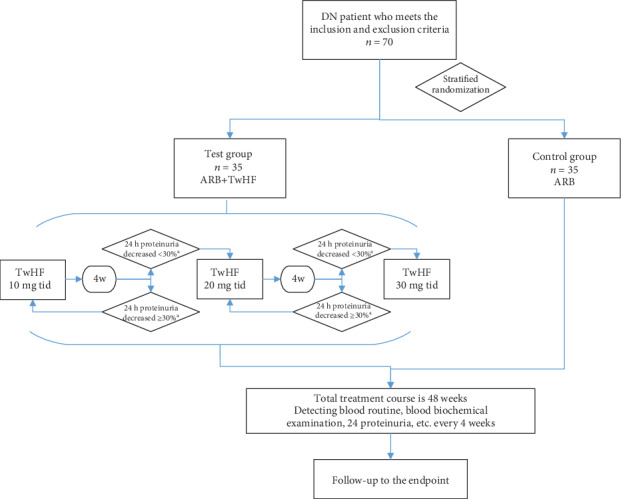
Study process. aCompared with baseline. DN: diabetic nephropathy; ARB: angiotensin receptor blocker; TwHF: Tripterygium wilfordii Hook F.